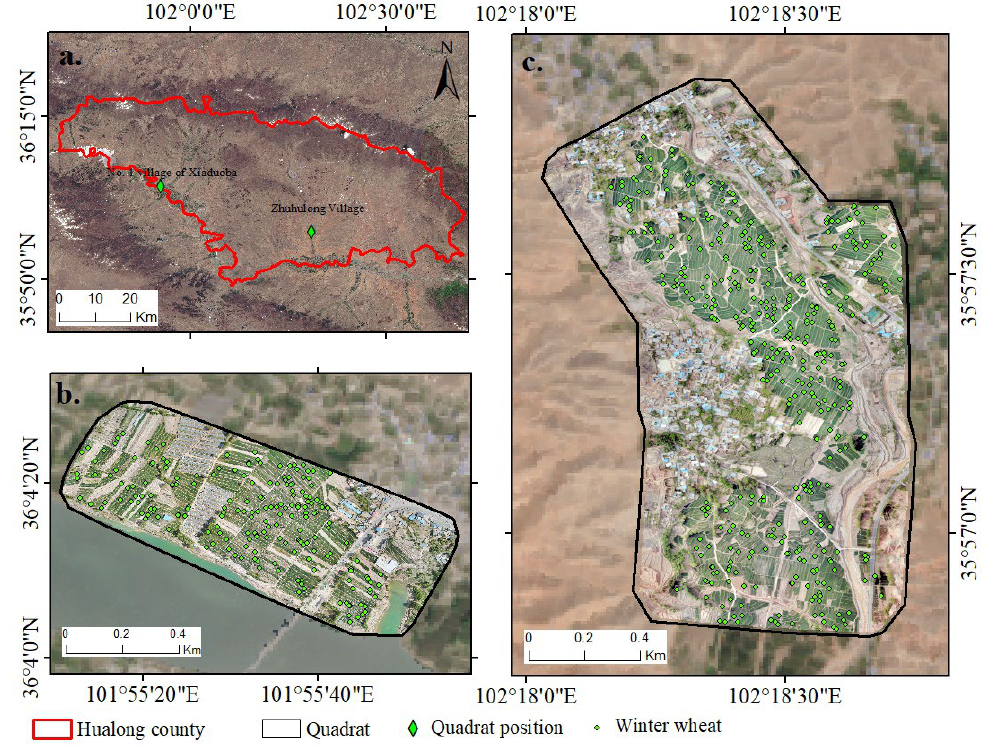
Figure 2. ( a ) Location of two quadrats; ( b ) Quadrat 1; ( c ) Quadrat 2.